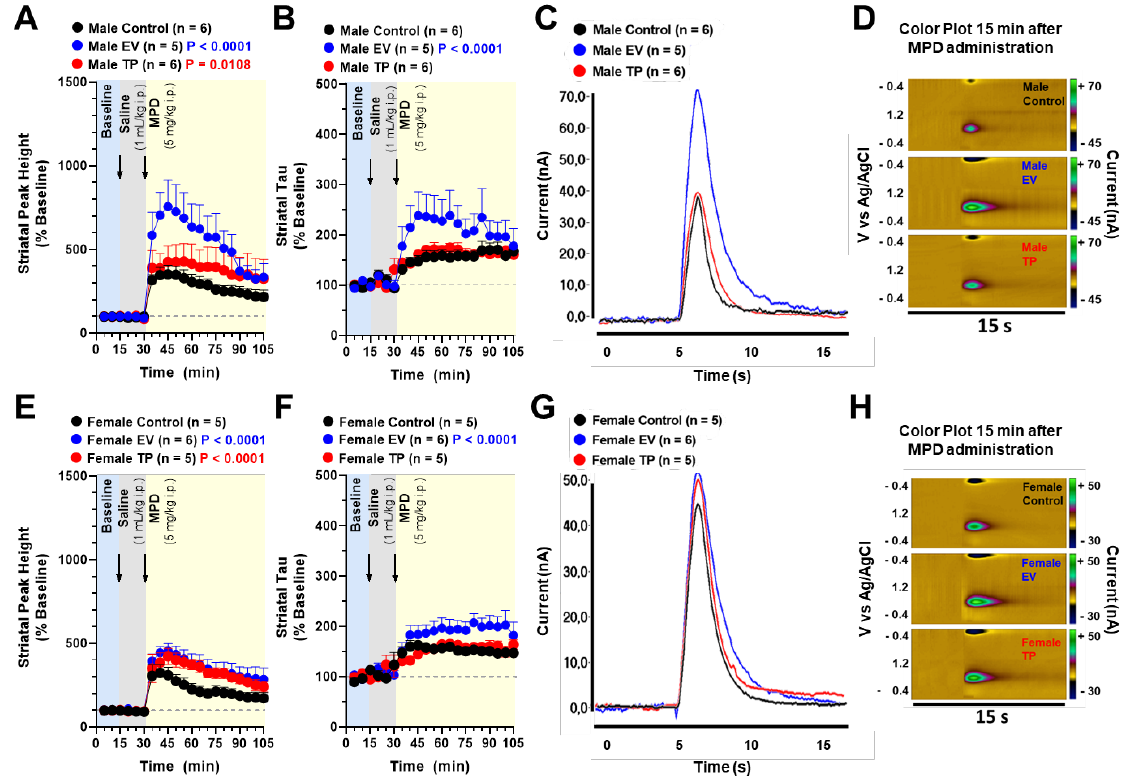
Figure 4. DA release and uptake dynamics obtained in DS before and after the acute i.p. MPH ad- ministration. Graphs represent the time course of electrically evoked DA release expressed as per- cent of the baseline shown as mean ± SEM for male ( A ) and female ( E ) rats neonatally treated with estradiol valerate (EV) or testosterone propionate (TP). Clearance for phasic DA (Tau) was meas- ured under the same conditions for male ( B ) and female ( F ) rats. Example evoked DA traces in response to MPD administration for male ( C ) and female ( G ) rats. Color plot representations of cyclic voltametric data collected over 15 s for male ( D ) and female ( H ) rats. The current generated by oxidation/reduction is depicted in color in response to the potential applied and the time of col- lection. Under these conditions, the oxidation of dopamine occurs at 0.6 V. Data were analyzed by two-way